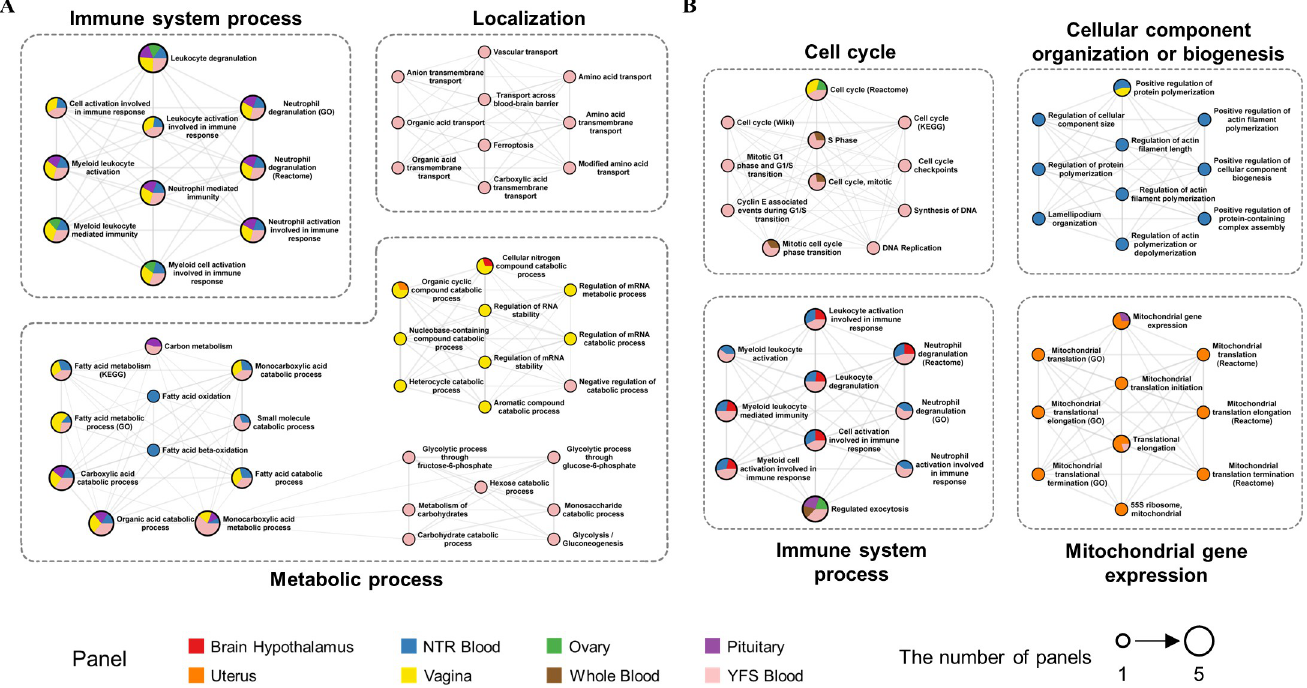
Fig 3. Functional annotation networks consisting of biological pathways enriched with TWAS genes for UF. ( A ) Four major clusters grouped into three parental biological pathways were enriched with positively associated TWAS genes (TWAS P-value < 0.05 and Z-score > 0). ( B ) Four major clusters of biological pathways were enriched with negatively associated TWAS genes (TWAS P-value < 0.05 and Z-score < 0). The major clusters are the sub-networks in the top 25% for connectivity score as calculated by the MCODE in each functional annotation network. Each node represented by a pie chart indicates an enriched biological pathway, and the sector size is proportional to the number of genes that originate from each tissue panel. The node size corresponds to the number of panels where TWAS genes were enriched.